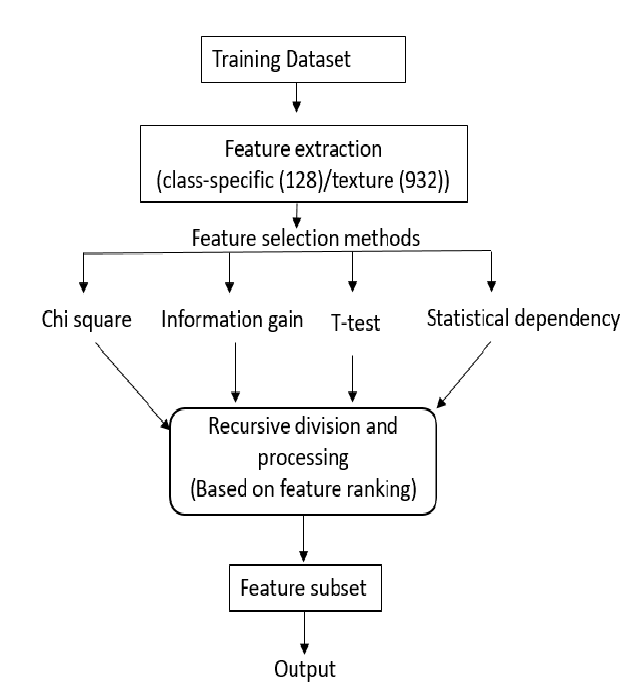
Figure 2. Architecture of proposed scheme for feature